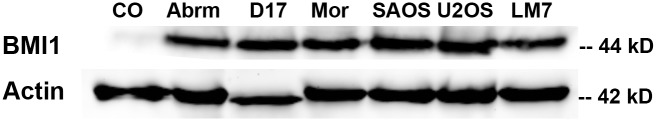
Protein expression of BMI1 in human and canine OSA cell lines.Western blot analysis of canine and human OSA cell lines revealed high expression of BMI1 relative to the normal canine osteoblasts (CO). Due to close proximity and strong signals for both BMI1 and Actin, two identical gels were loaded and protein electrophoresis and transfer were performed in parallel. Separate membranes were then probed with antibodies against BMI1 and Actin as shown. Abrm = Abrams, Mor = Moresco.